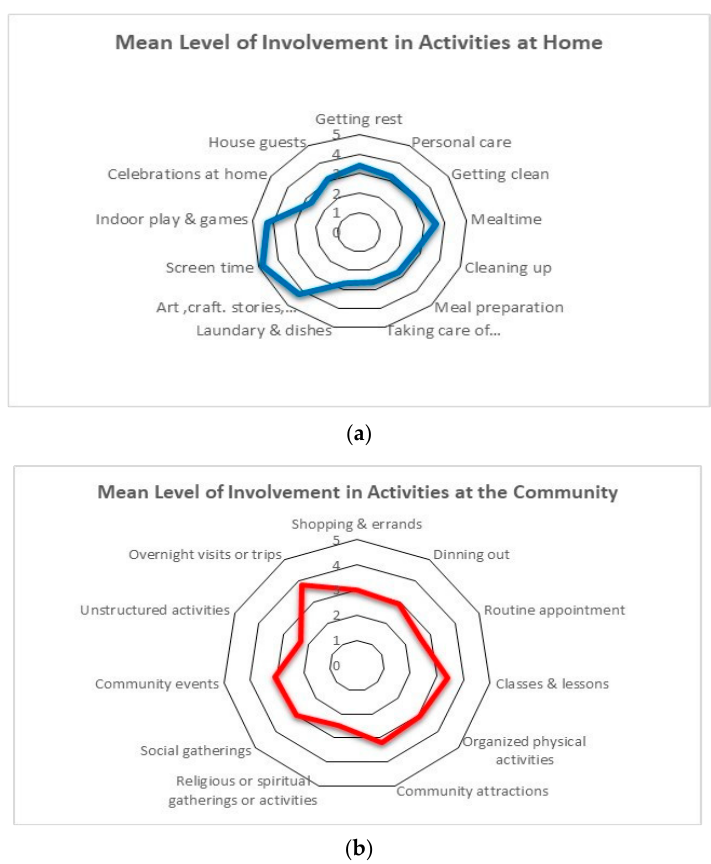
Figure 2. ( a ) Mean level of involvement in activities at home, ( b ) mean level of involvement in activities in the Community.